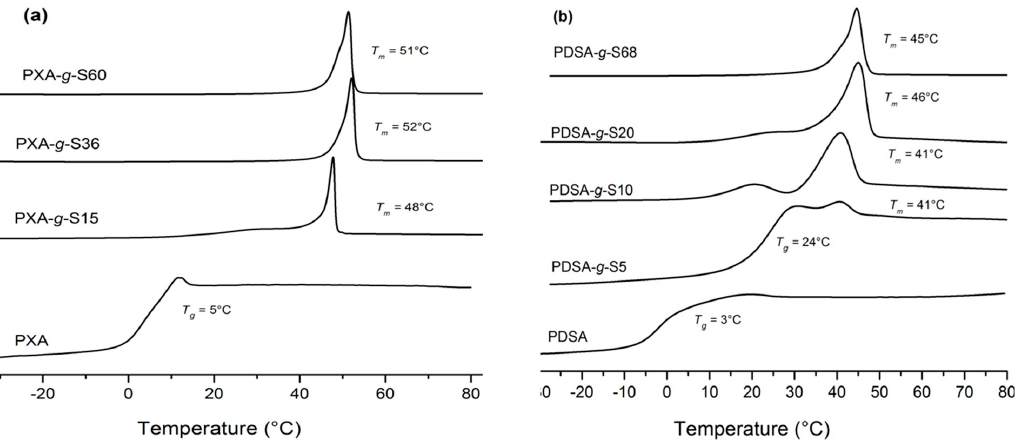
Figure 2 . Size exclusion chromatography (SEC) traces of ( a ) stearoyl grafed poly(xylitol adipate) in THF; ( b ) SEC traces of stearoyl grafted poly( D -sorbitol adipate) in THF. The insets show the SEC traces of the polymer backbones PXA and PDSA, respectively, in DMF.